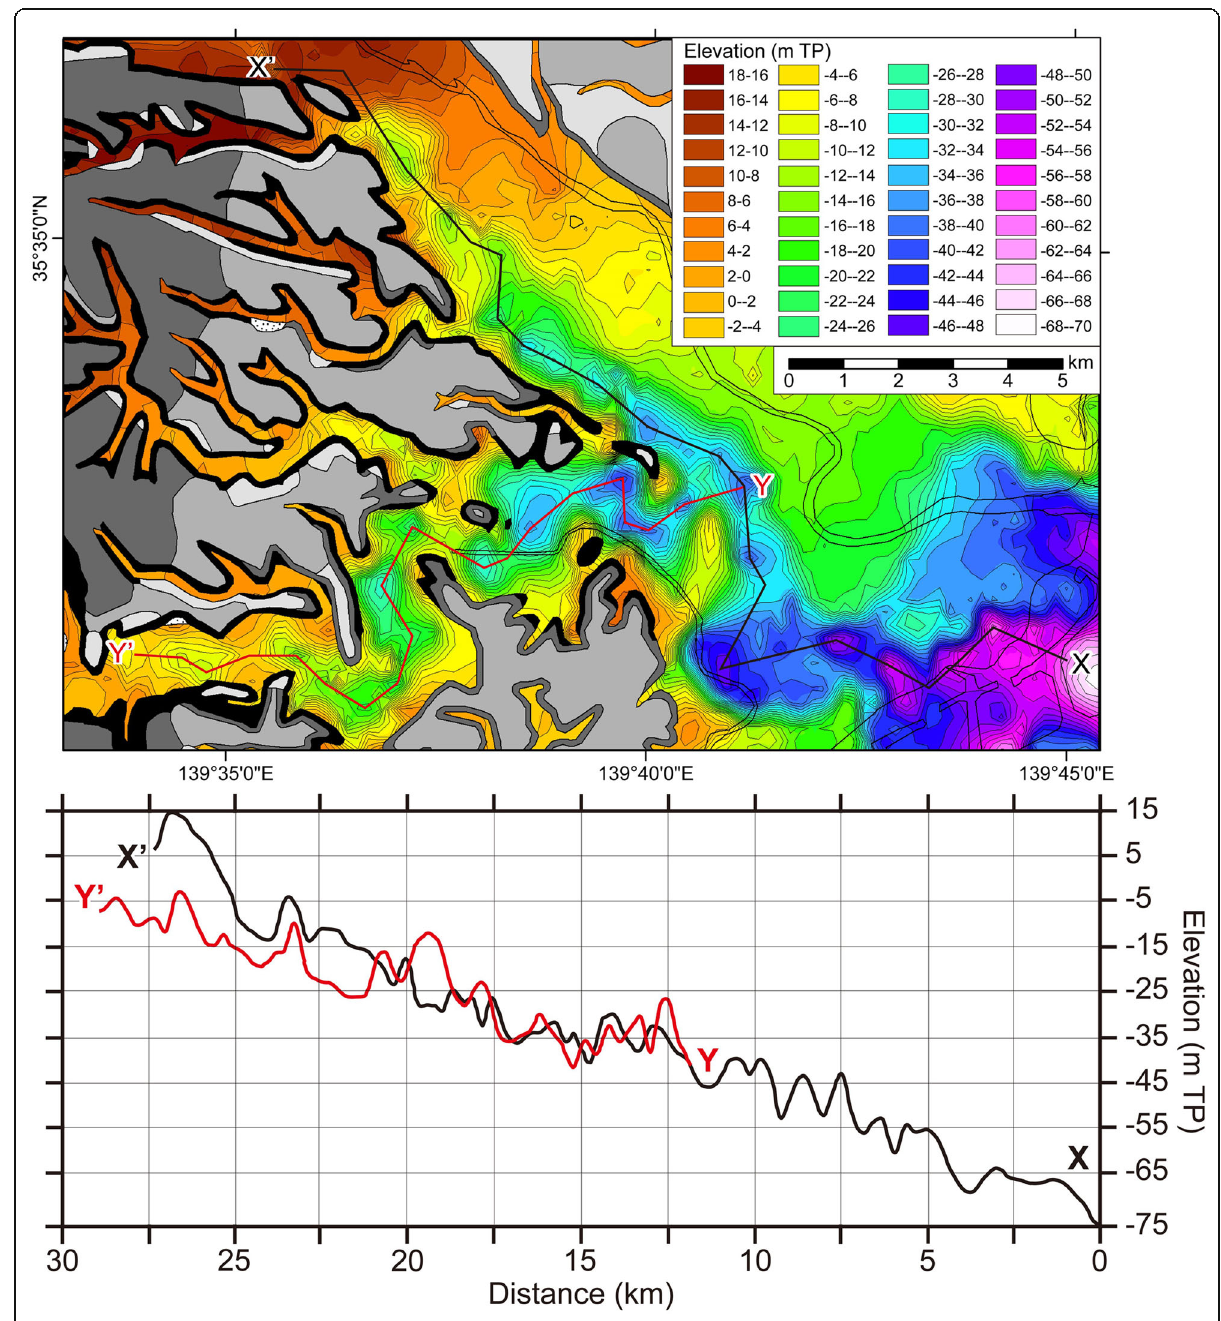
Fig. 12 Thalwegs of the Tama (black line, XX ’ ) and Tsurumi (red line YY ’ ) river